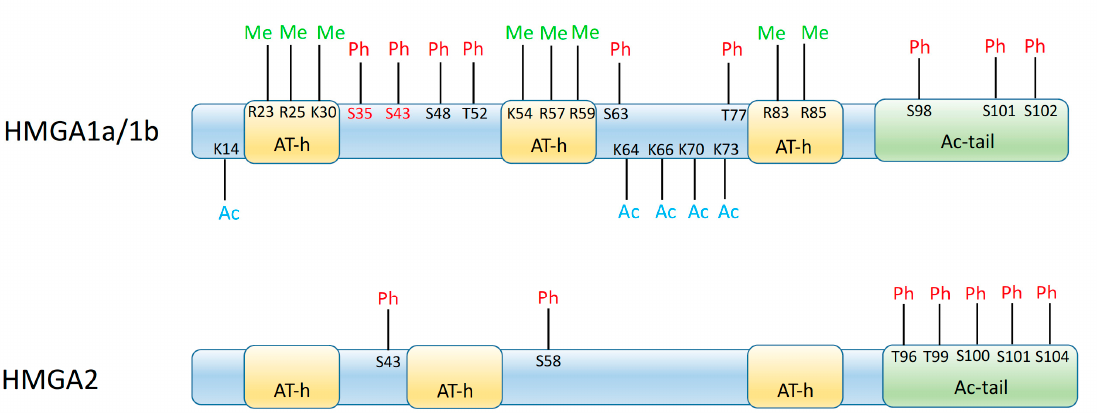
Figure 1. Schematics of the functional organization of HMGA1 and HMGA2 proteins, showing the AT-hook domains (AT-h) and the acidic terminal tail (Ac-tail) of the proteins, as well as the residues that may be modified by acetylation (Ac), phosphorylation (Ph), or methylation (Me). Numbers indicate the position of these residues in the mature protein (initial methionine is removed post-translationally); for the HMGA1a / HMGA1b scheme they refer to the HMGA1a sequence; residues in red are only present in HMGA1a and spliced out from HMGA1b, while those in black are present both in HMGA1a and HMGA1b.